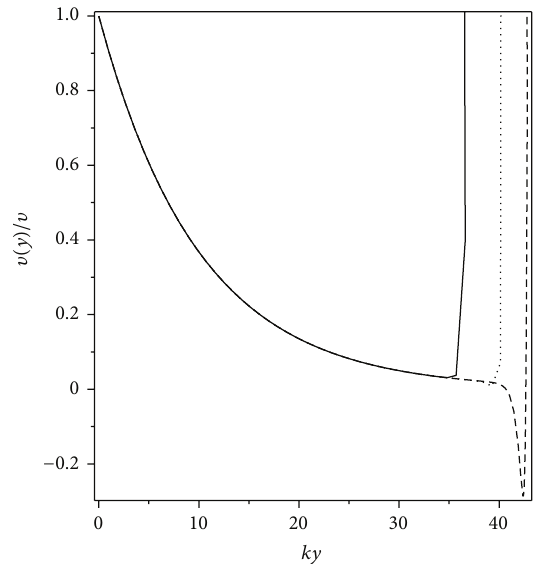
Figure 4: The VEV profile for large positive brane cosmological constant with ℵ = 20 (dotted line), ℵ = 28 (dashed line), and ℵ = ∞ (solid line, i.e., RS case) in the (𝑁,𝐷) case for ̃𝜆 values of other parameters of the model are the same as the ones in Figure 1.